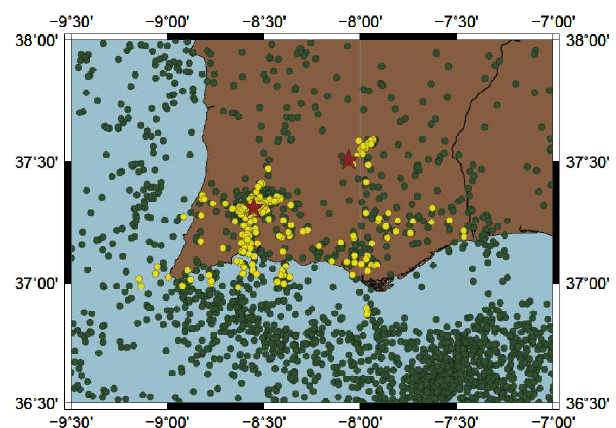
Fig. 2. Yellow circles represent the micro-seismicity (1 <M < 3) of the South of Portugal acquired with the network described in Rocha et al. (2008), for nearly 4 years of observation. Green circles stand for the seismic records from IM database from 1961–2009. The red stars show the planned locations to host the ULF three-component